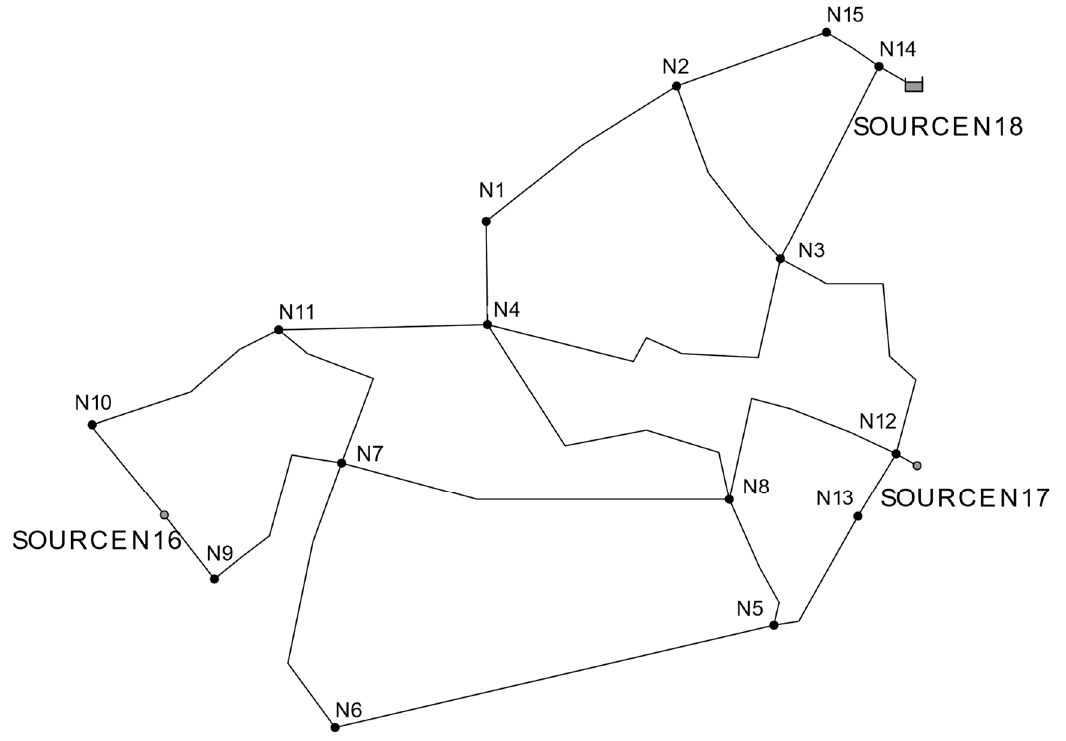
Figure 2. The TF distribution network. Table 1. Nodes of the TF network.